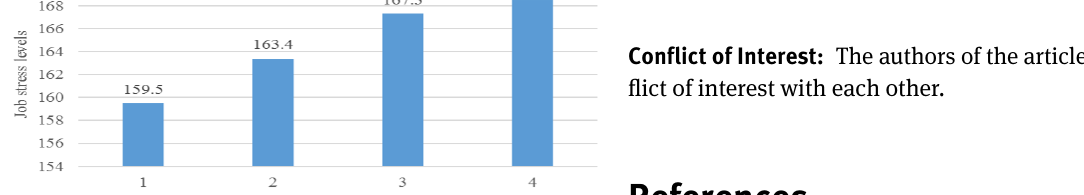
Figure 5: Relationship between job stress and the number of recorded traflc